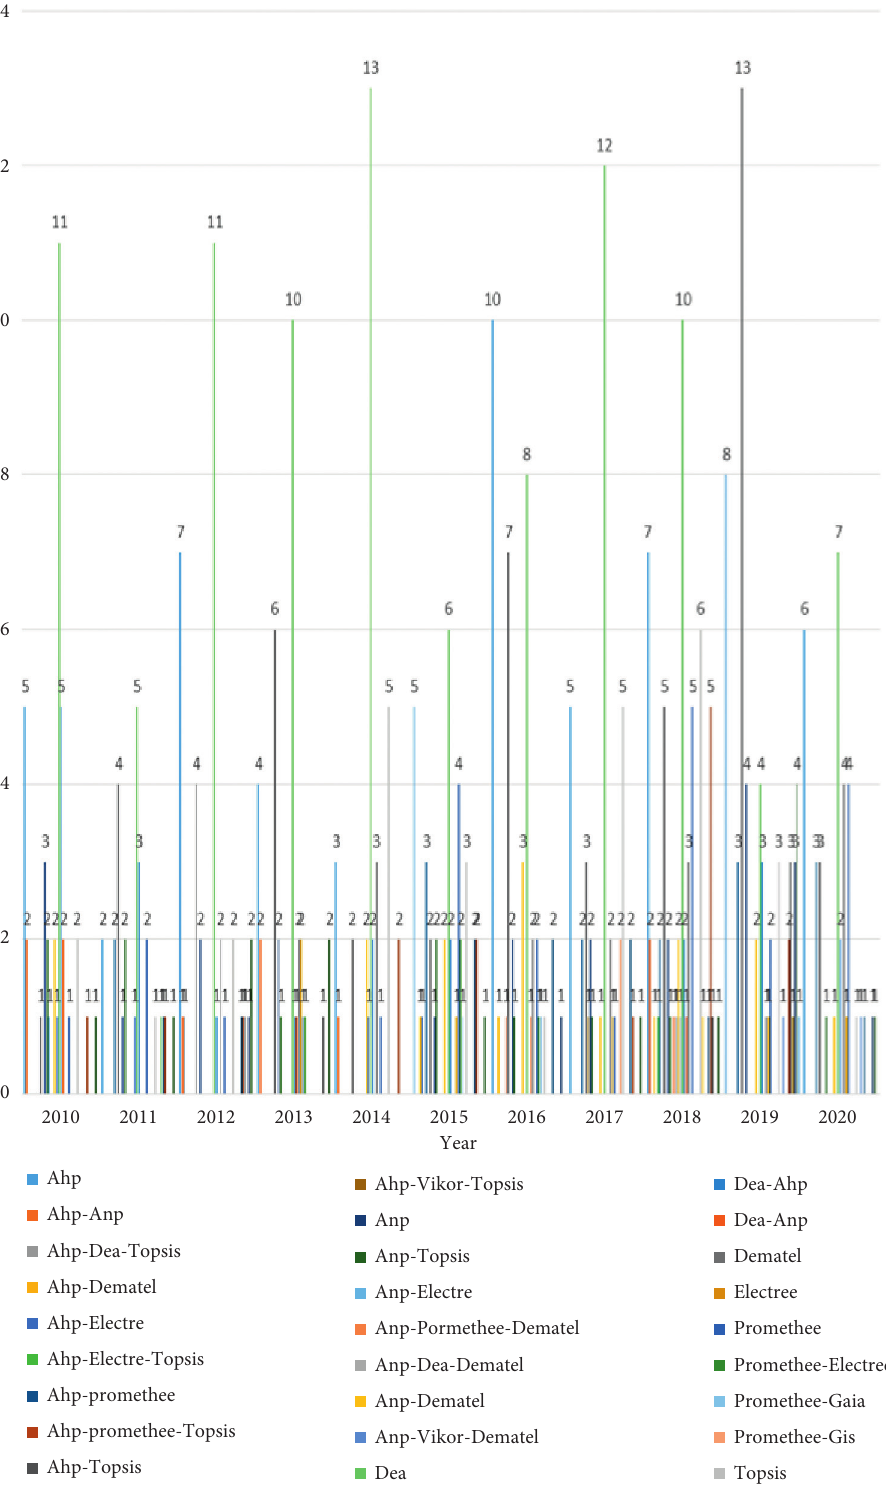
Figure 6: Crosstabulation of studies by year and specific